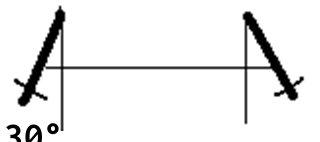
Figure 12. Input value of vertical propellers for depth control. As can be seen from the depth control quantity, the control quantity has a direct current component to overcome the buoyancy force on the vehicle carrier when it is stable. The averaged data in the stationary section is U = 55.062, which is the same unit as the control quantity Tz in the vertical plane. The arrangement of the vertical propeller is shown in Figure 13.